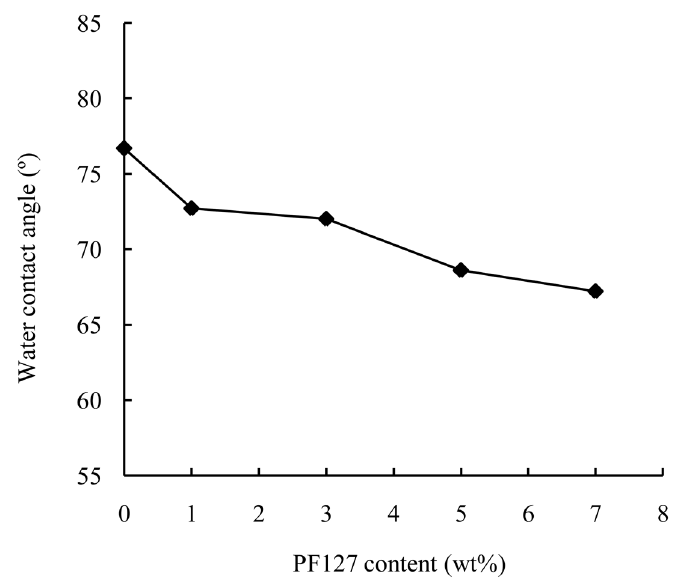
Figure 4. The value of the water contact angle of the PVC membrane based on the concentration of PF127 (n=10 per PF127